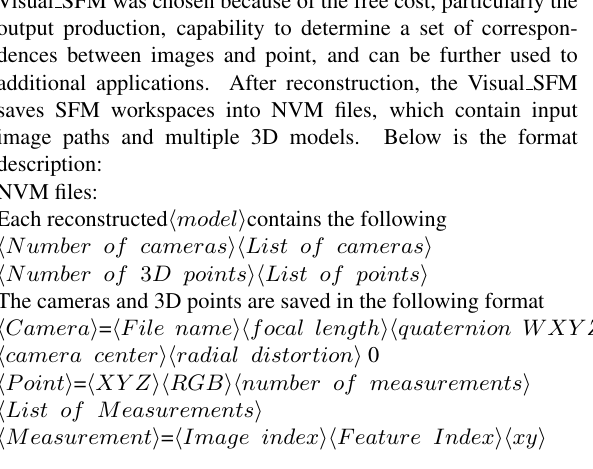
Figure 2. RGB image of the study area